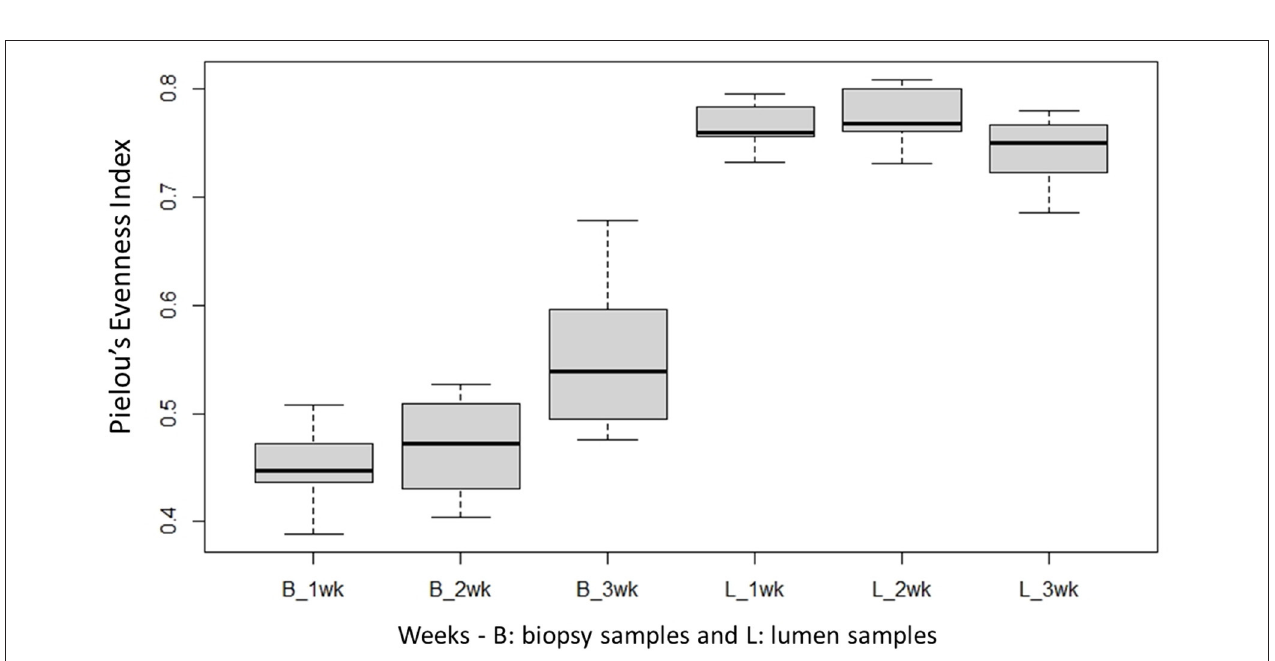
FIGURE 4 | Comparison of the average bacterial OTU‘s Pielou’s evenness index for the mucosal surface (B, biopsy) and lumen contents (L, lumen samples) for each week sampled.